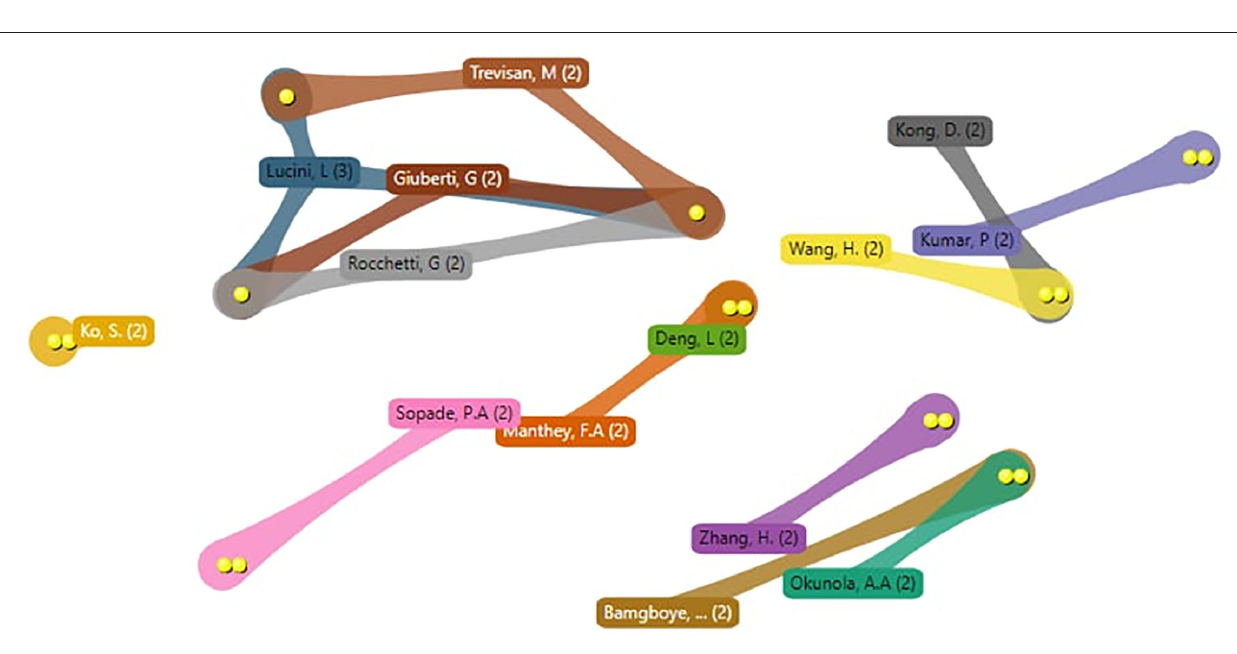
FIGURE 7 | Authors’ poster. Source: Vantage point software (through information provided by the